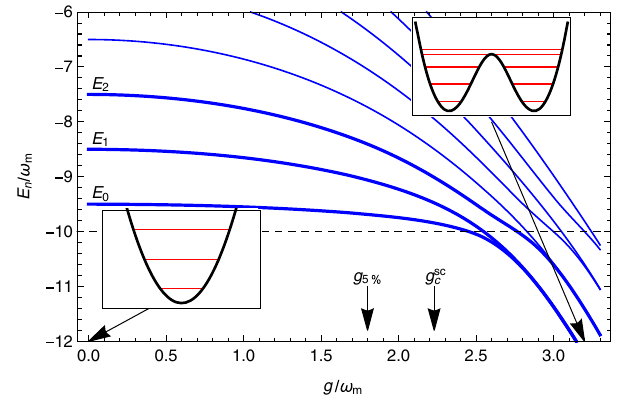
of the Hamiltonian n as a function of g= ω . The Born- m m . The dashed m = ω c m ¼ ffiffiffi ≈ 1 . 8 ω for which the anhar- 5% m